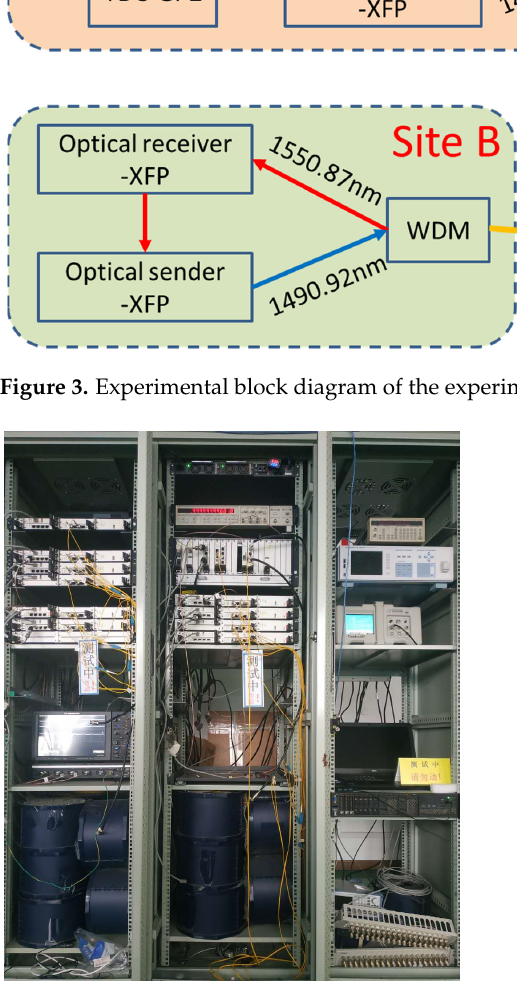
Figure 4. The physical diagram of the experimental platform.